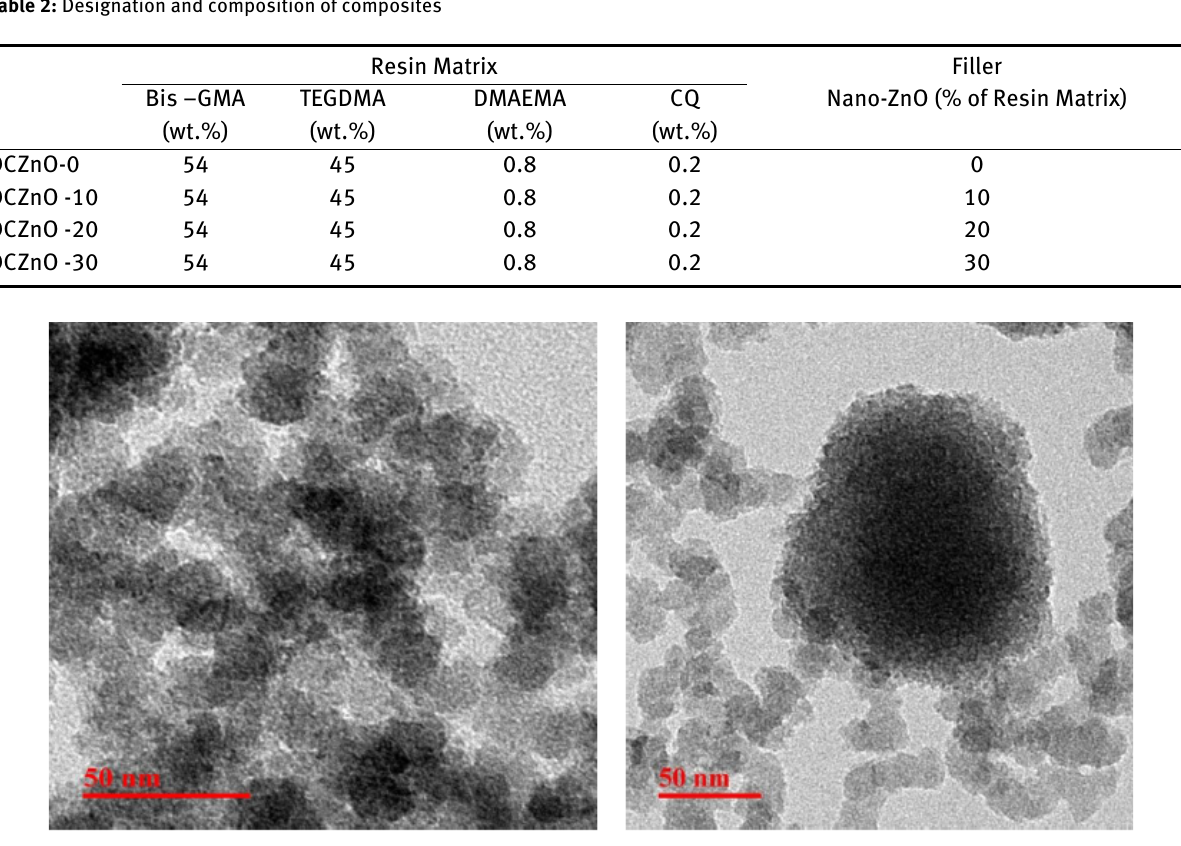
Figure 2: TEM images of nanoZnO filler (a) after silane treatment (b) before silane treatment